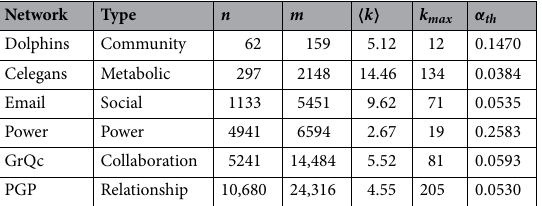
Table 4. Topological parameters of six real networks: node number n , edge number m , maximum degree k max , and spread threshold α th 55 .